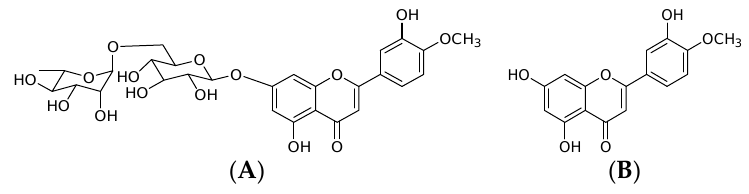
Figure 1. Chemical structure of diosmin ( A ) and diosmetin ( B ).